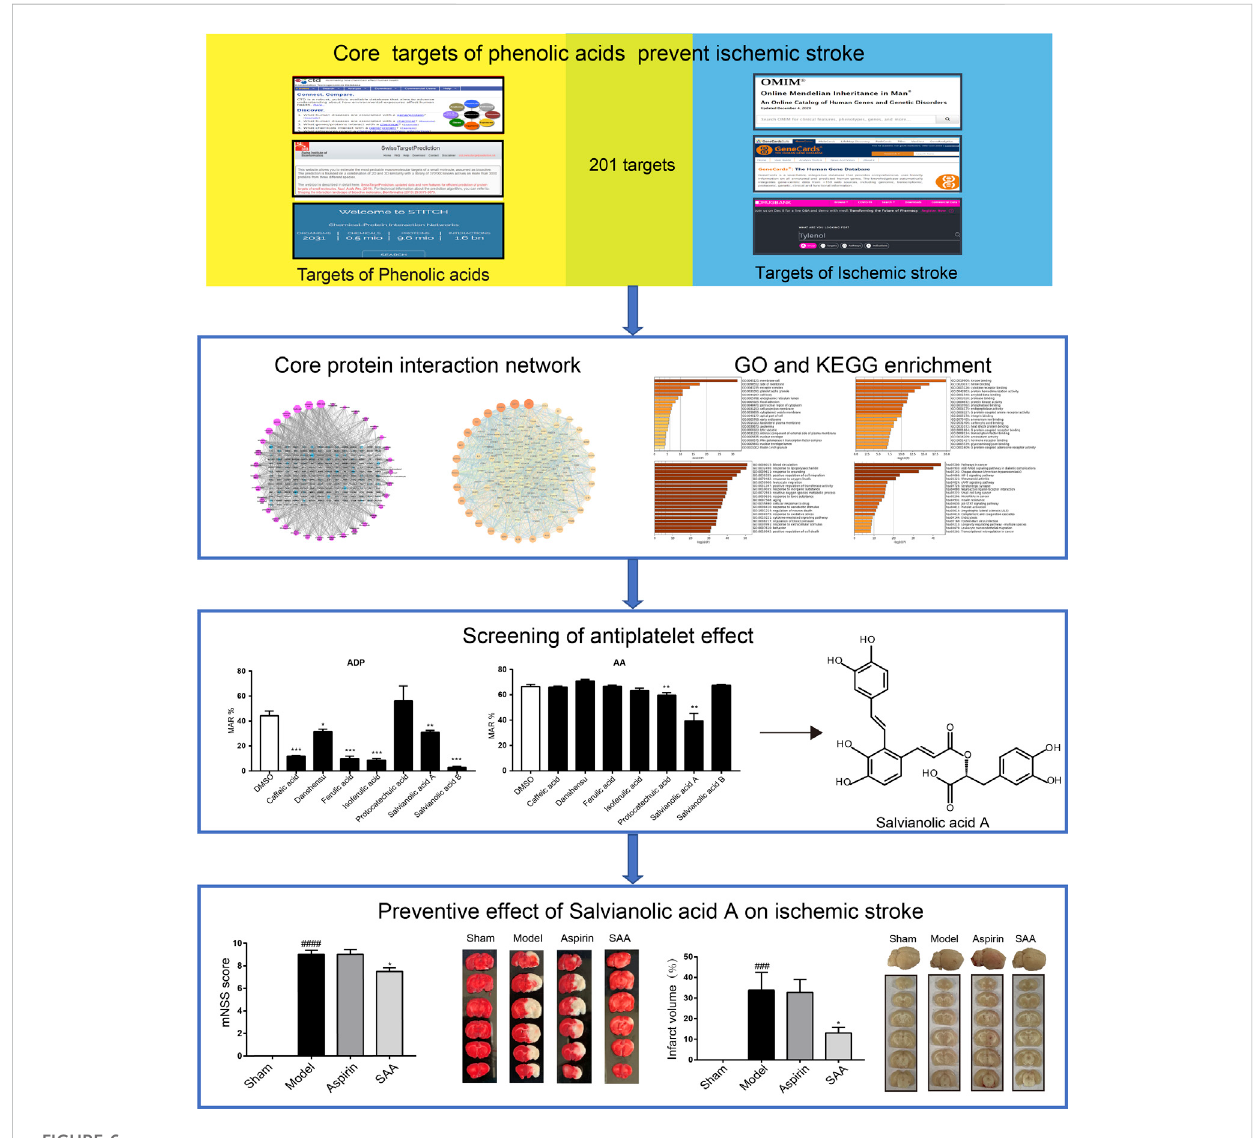
FIGURE 6 Work scheme of the present